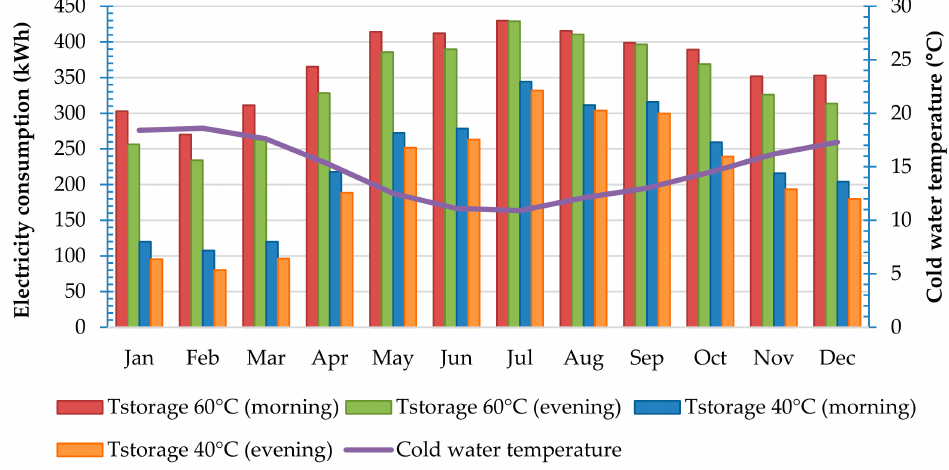
Figure 8. Electricity consumption using solar heating systems with a boiler in Curitiba.